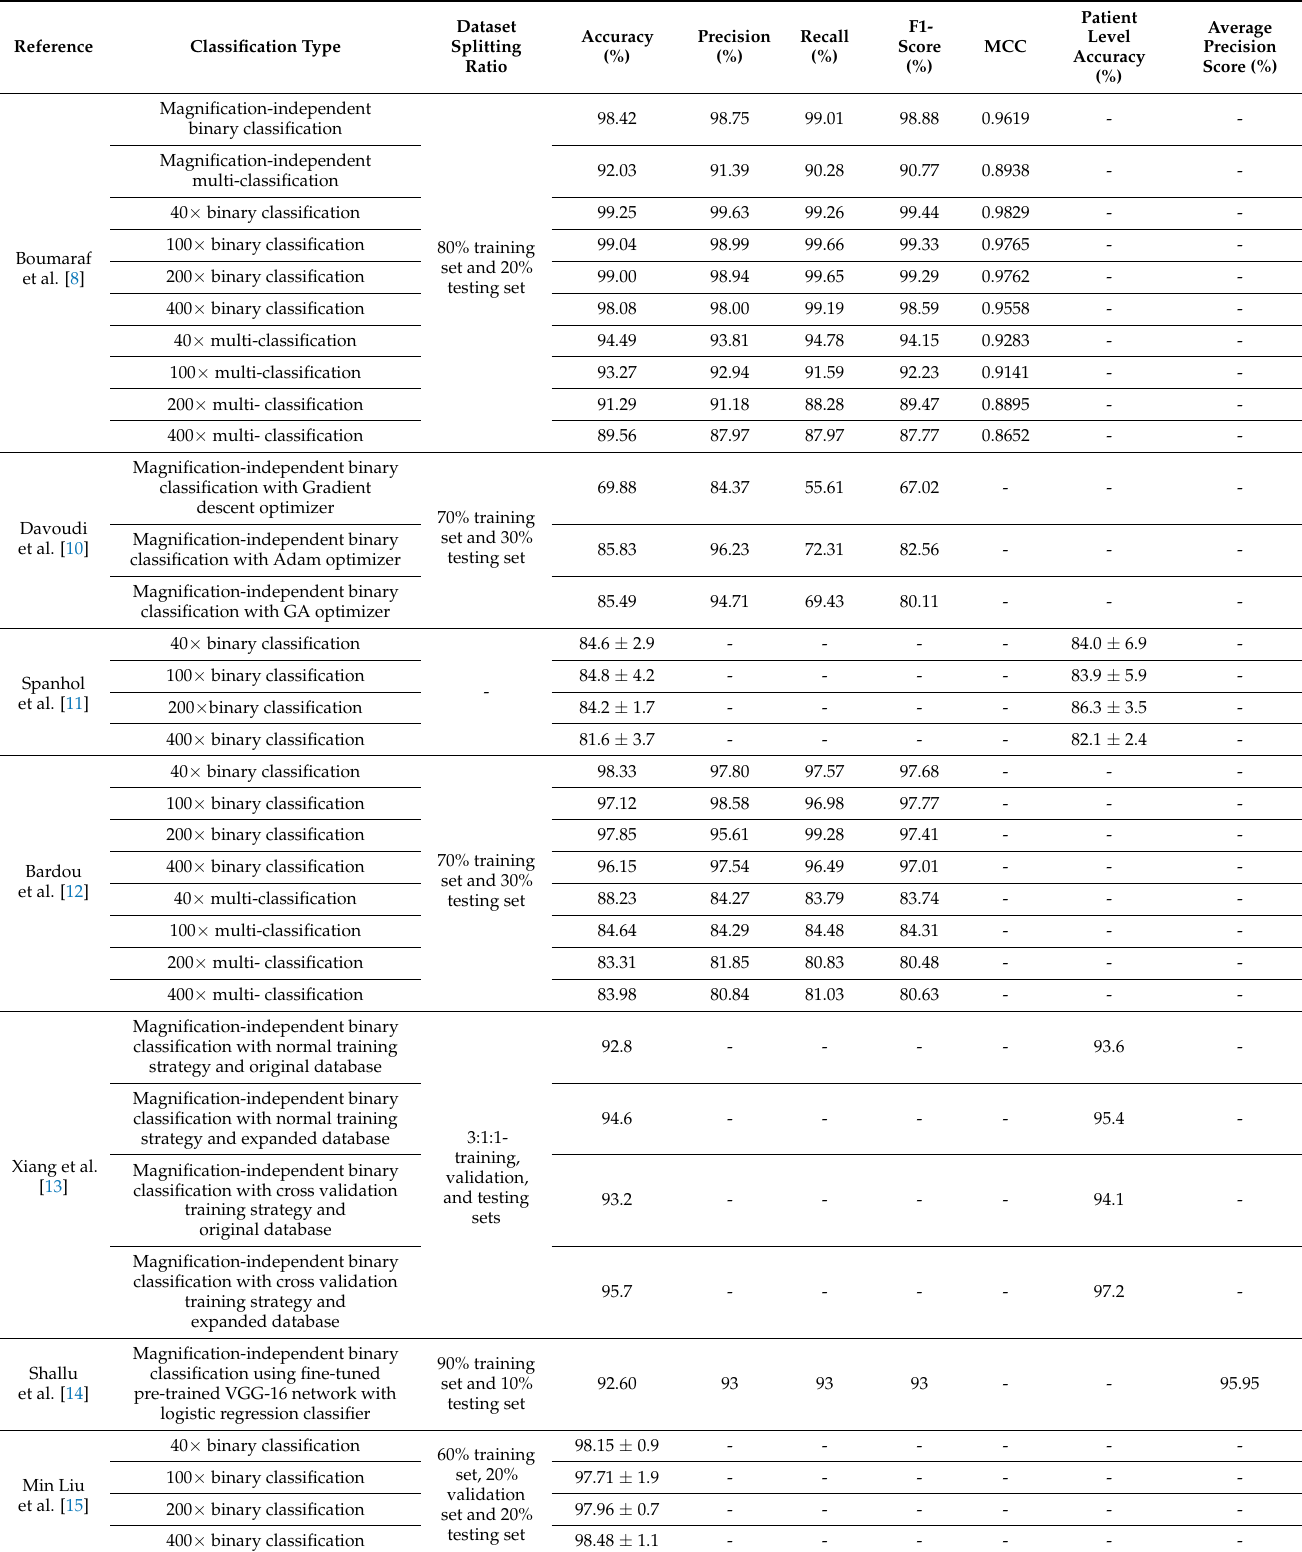
Table 1. Performance results achieved by the related